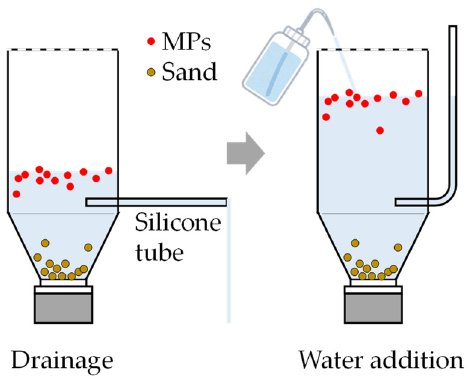
Figure 8. Dilution and washing of flotation medium by bottle method.